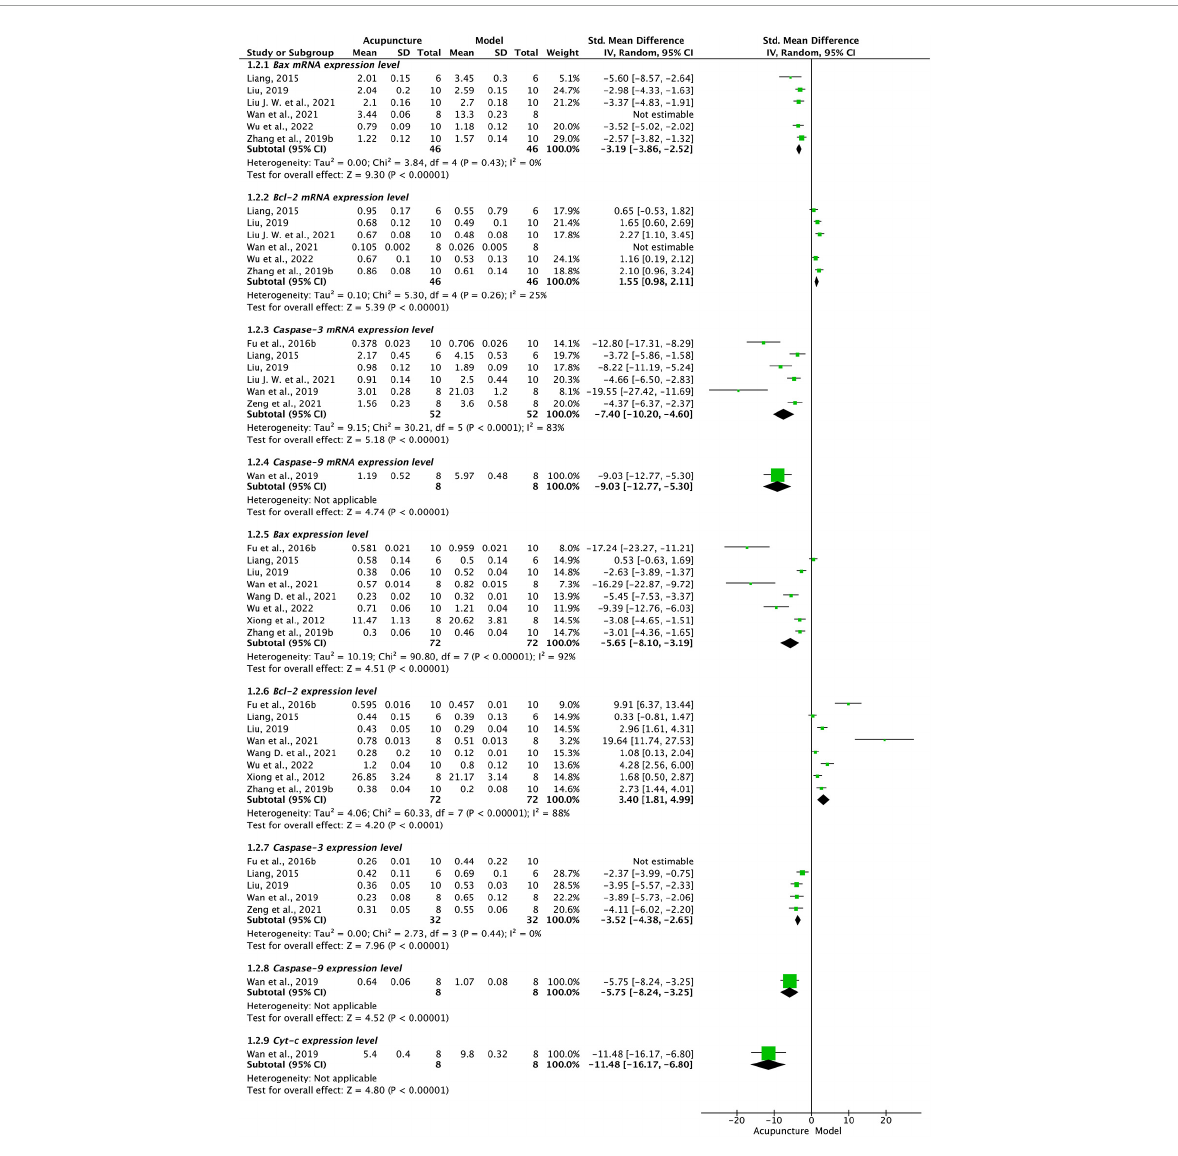
FIGURE3 Forest plot of signaling regulator of mitochondria pathway. Bax mRNA, Bcl-2 mRNA, Caspase-3 mRNA, Caspase-9 mRNA, Bax, Bcl-2, Caspase-3, Caspase-9, Cyt-c in acupuncture and model